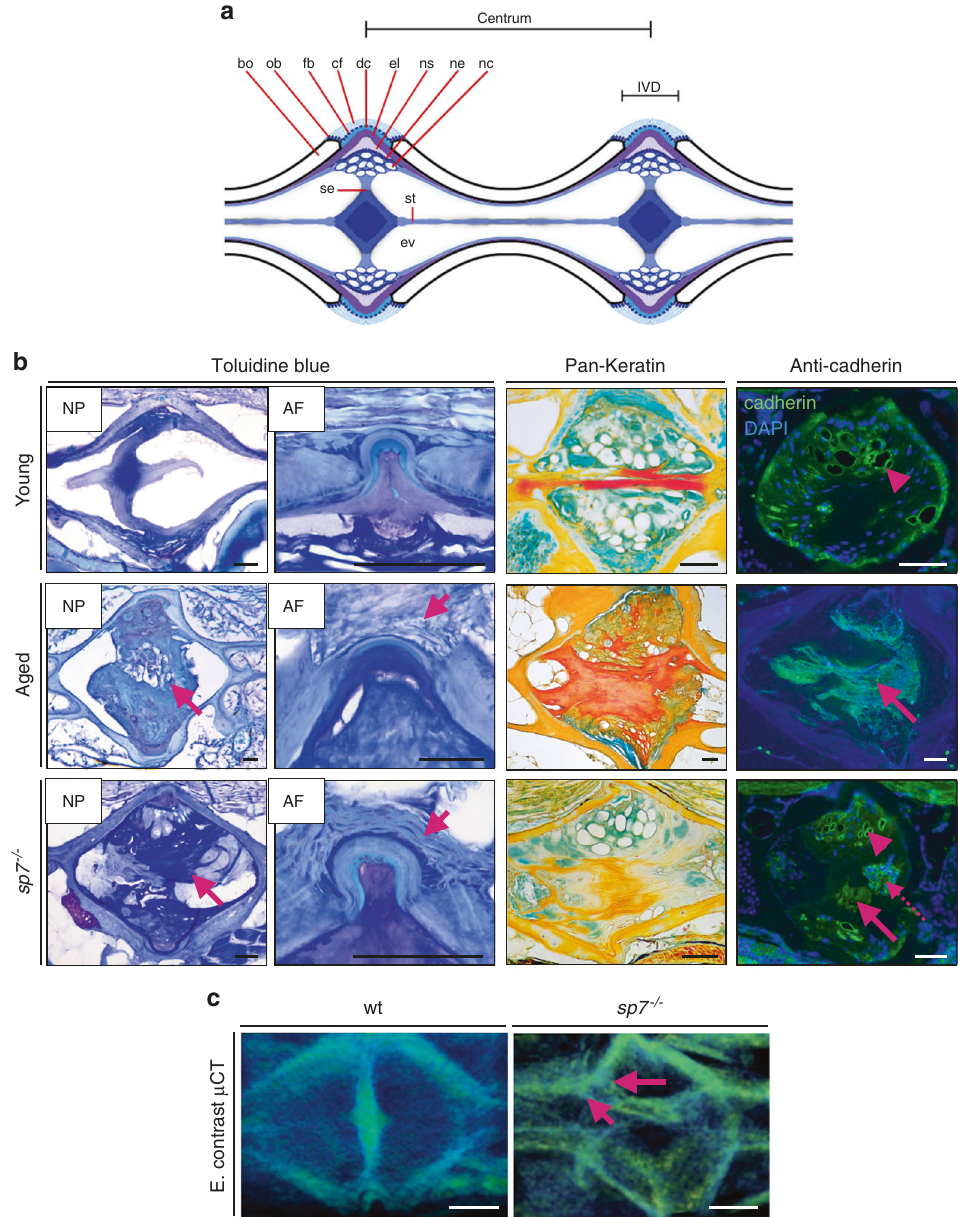
Fig. 5 IVDD histopathology underlying 3D disc changes in zebra fi sh. a Schematic of the vertebral segments of the zebra fi sh. IVDD histopathology underlying 3D disc changes in zebra fi sh. The centrum and IVD regions are annotated. bo, bone; cf, collagen type I fi ber bundles; dc, dense collagen type I matrix; el, elastin; ev, extracellular vacuole; fb, fi broblasts; nc, notochord cells, vacuolated cells and notochord epithelial cells attached to the notochord sheath; ne, notochord epithelium; ns, notochord sheath; ob, osteoblasts; se, septum; st, notochord strand. b Toluidine blue, pankeratin and pan cadherin immunostaining of young (1 y), aged (3 y), and sp7 − / − (1 y) discs. Toluidine blue of a middle section of the disc showing the NP in young, aged, and sp7 − / − discs ( n = 3 per group, serial sections were analyzed). Note the fi brous and disorganized NP in aged and sp7 − / − (magenta arrows) discs. Higher magni fi cation, with a focus on the AF, is shown on the right. Note collagen bundle fi bers disrupted in the aged AF and loose organization in the sp7 − / − disc (magenta arrows). Pankeratin showing bone (yellow), keratin (orange), and glycosaminoglycans (green). Note the accumulation of keratin in aged discs and dehydration (weak stain for glycosaminoglycans) in aged and sp7 − / − discs. Immunostaining for pan cadherin showing the loss of cellularity in aged discs (arrow) and disorganized NPs in sp7 − / − discs, with vacuolated cells (pink arrowhead), acellular regions (pink arrow), and cellular agglomerates (pink dashed arrow) ( n = 3 per group, ≥ 3 sections analyzed). Scale bars = 50 μ m. c 3D volumetric rendering from enhanced (E) contrast μ CT images of wt (1 y) and sp7 − / − (1 y) zebra fi sh. Note fi brous tissue organization in sp7 − / − zebra fi sh. Arrows point to an abnormal notochord sheath layer. Scale bars = 50 μ chondrodystrophoid dog are the most studied species in which and disc herniation, recapitulating chronic cases of human IVDD. spontaneous IVDD occurs 63 . The mechanical load of discs in Several animal models and mechanisms to replicate IVDD have been proposed, but due to IVDD complexity, all forms quadrupedal mammals differs from that in humans, with of replication have limitations. The sand rat and the gravitational loading occurring perpendicular to the vertebral